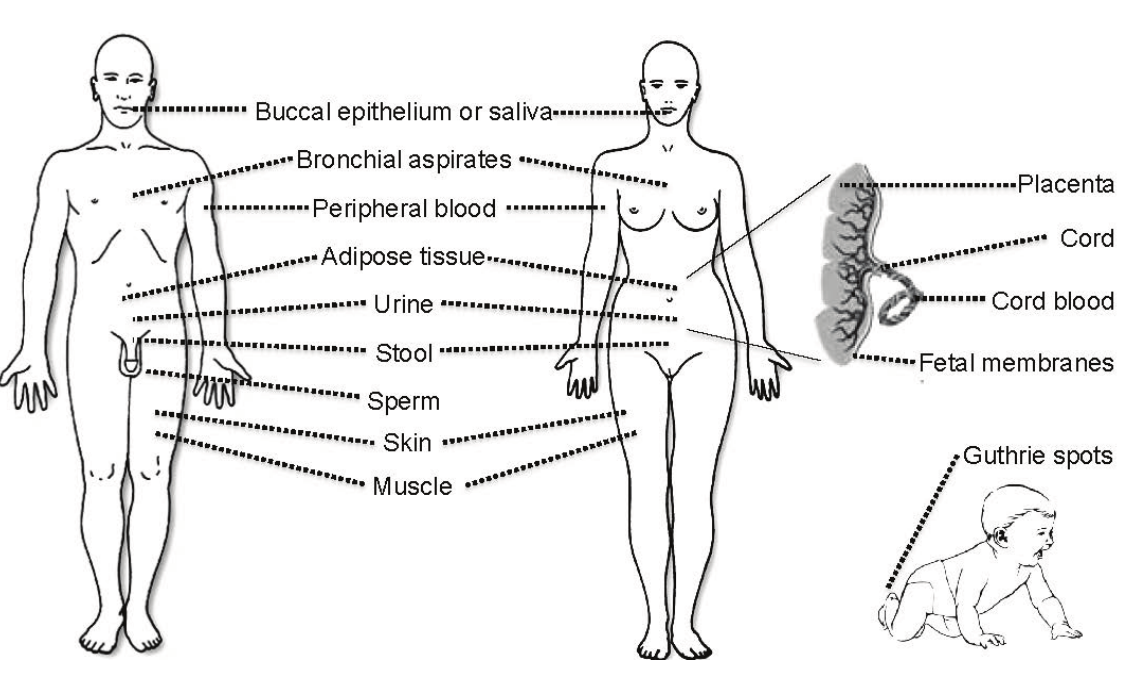
Figure 1. Illustration of the variety of tissues that can be used to investigate DNA methylation biomarkers. Note that tumor tissue is not listed individually as a cancer can affect any part of the